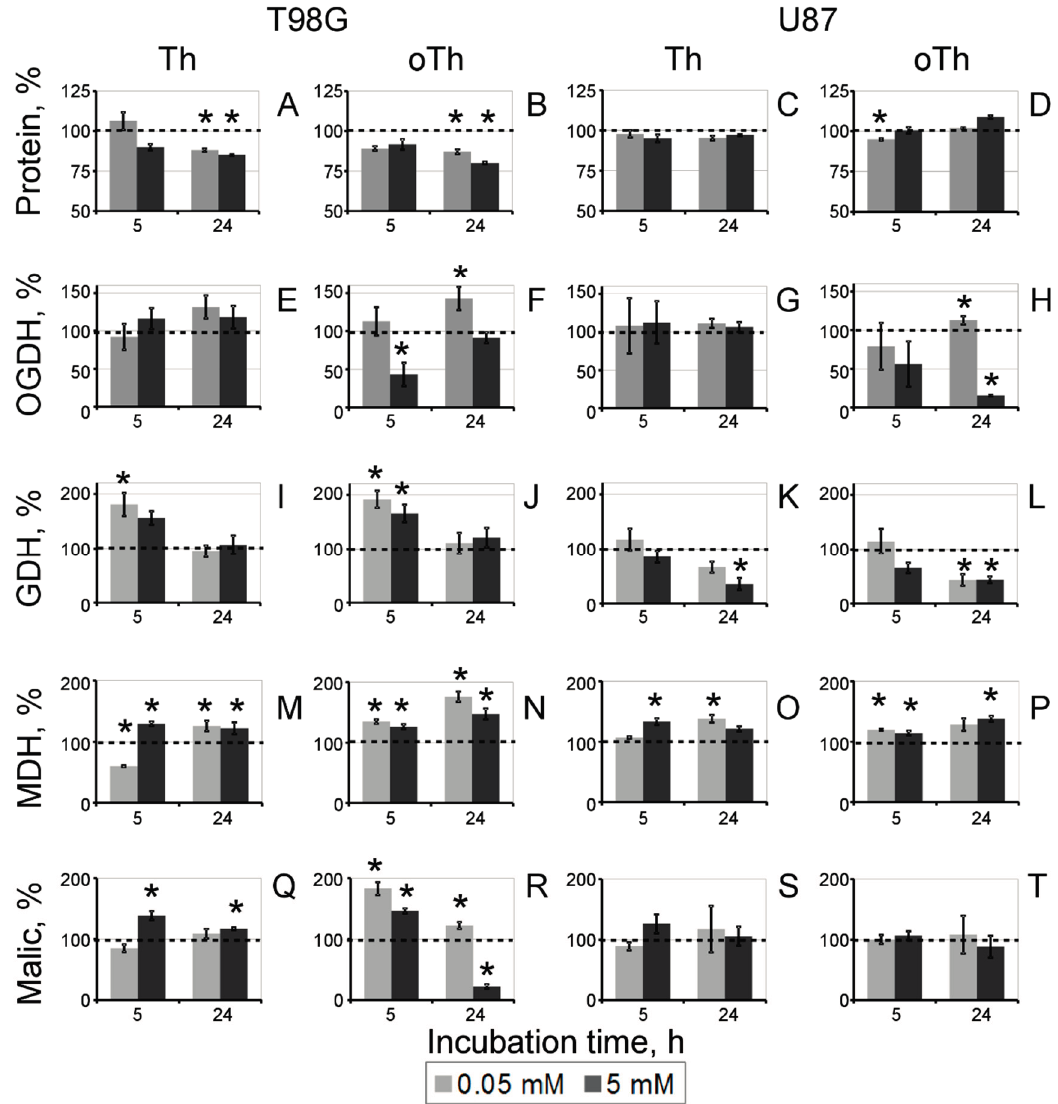
Figure 2. Concentration- and time-dependent changes in cellular protein ( A – D ) and activities of the ThDP-dependent (OGDH, E – H ) and affiliated (GDH, I – L ; MDH, M – P ; malic, Q – T ) enzymes upon incubation of T98G (left panel) and U87 (right panel) cells with thiamin (Th) and oxythiamin (oTh). Changes relative to the control values (Table 1) are shown as mean ± SEM, %. Significant differences with control (* p < 0.05) in the data groups at a fixed incubation time (5 h or 24 h) were determined by one-way ANOVA followed by post-hoc analysis using Dunnett’s Multiple Comparison